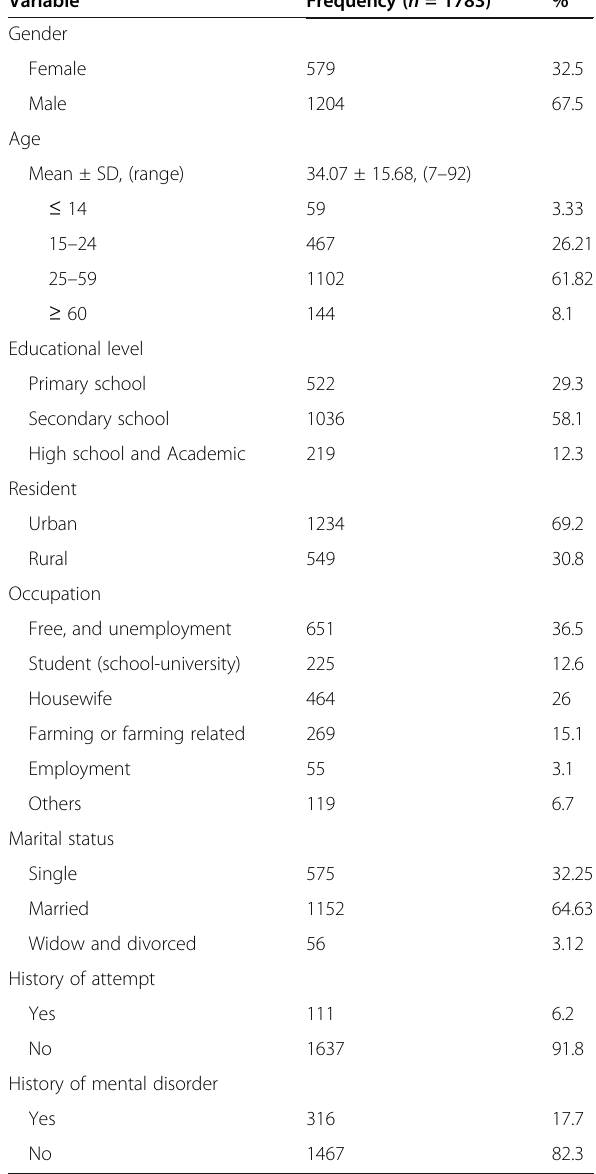
Table 1 Baseline characteristics of suicide deaths based on Death Registry Information System in East Azerbaijan Province, during